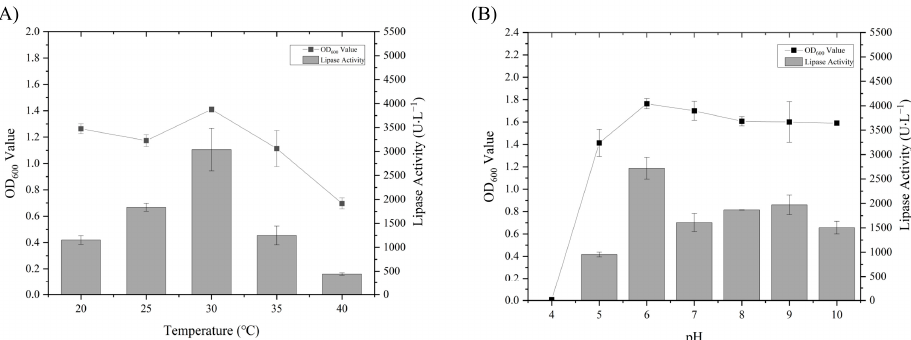
Figure 3. Growth characteristics and lipase activity of strain WCO-9: ( A ) growth of WCO-9 and lipase activity at different temperatures; ( B ) growth of WCO-9 and lipase activity under different pH conditions.